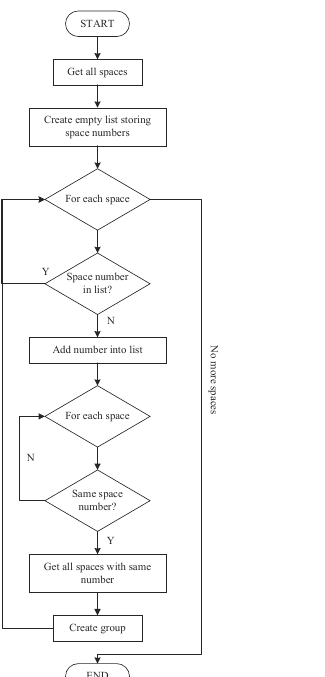
Figure 13. Flowchart of zoning common properties